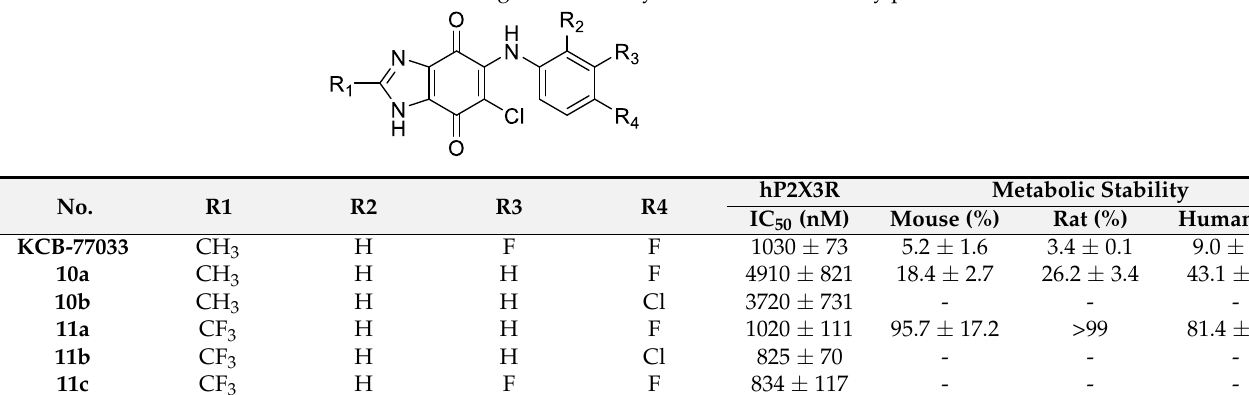
Table 1. The antagonistic activity and metabolic stability profile of the first set of derivatives.